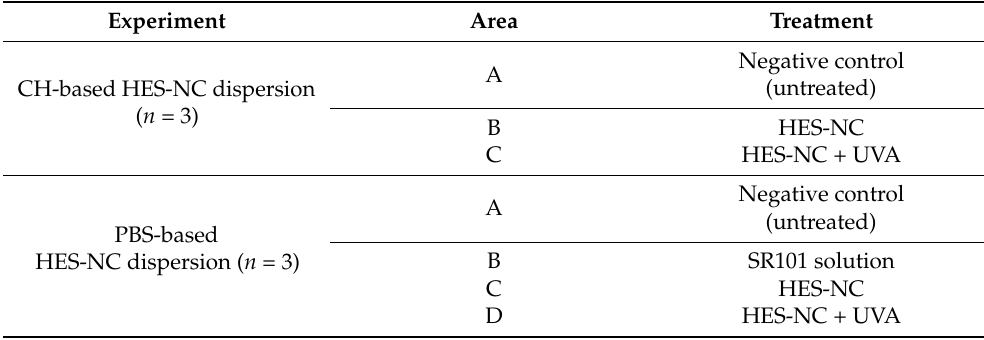
Table 2. Treatment scheme of ex vivo porcine skin with HES-NC dispersions in CH and PBS with and without UVA irradiation.